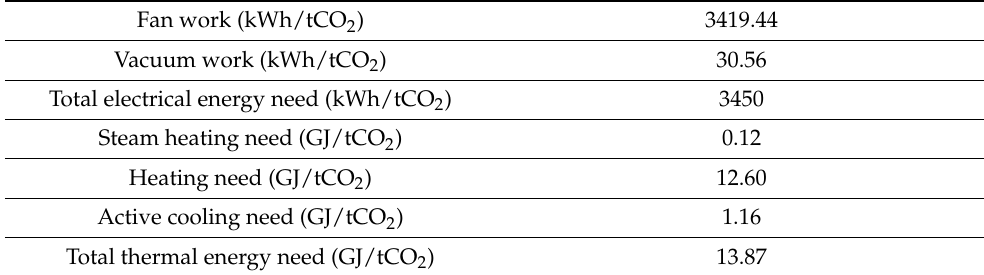
Table 9. Energy performance of the industrial module